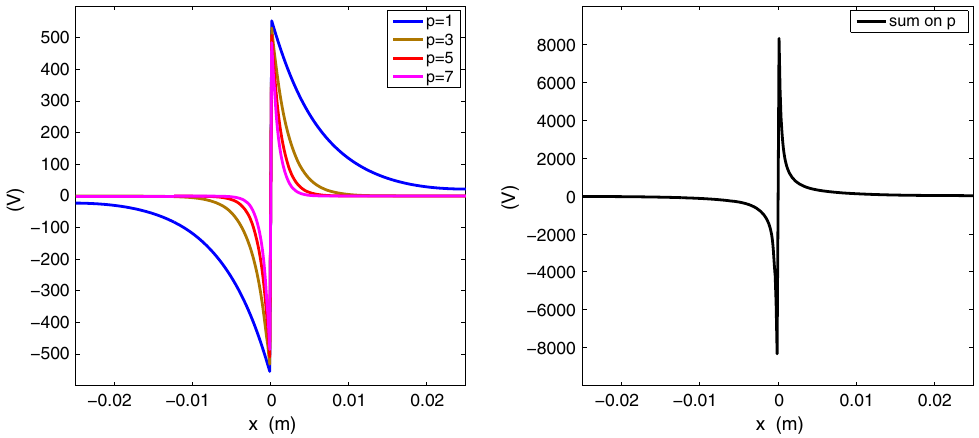
ˆ λ ˆ H x Þ . The factor ð k Þ is omitted. p ¼ 1 (blue); p ¼ 3 (brown); p ¼ 5 (red); yp ð x Þ yp ð